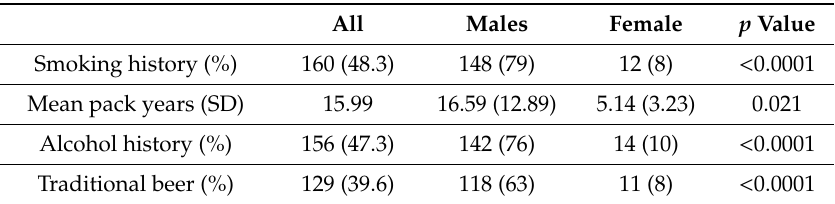
Table 2. Risk factors according to gender.